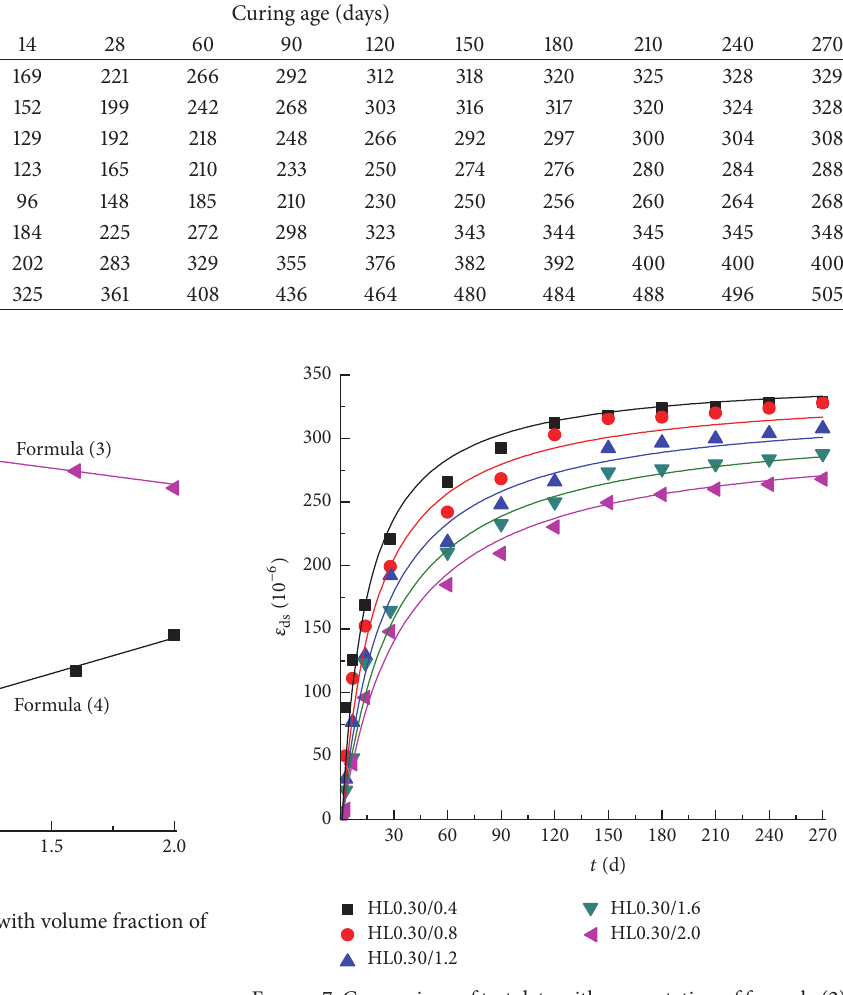
Figure 7: Comparison of test data with computation of formula (2).